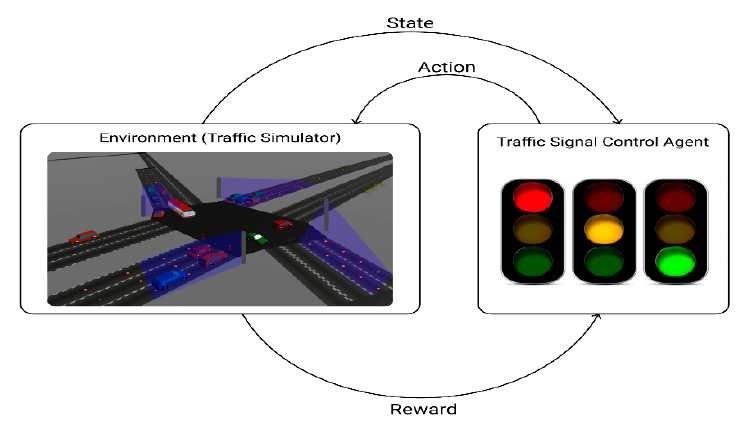
Figure 1. Reinforcement learning based traffic signal control.